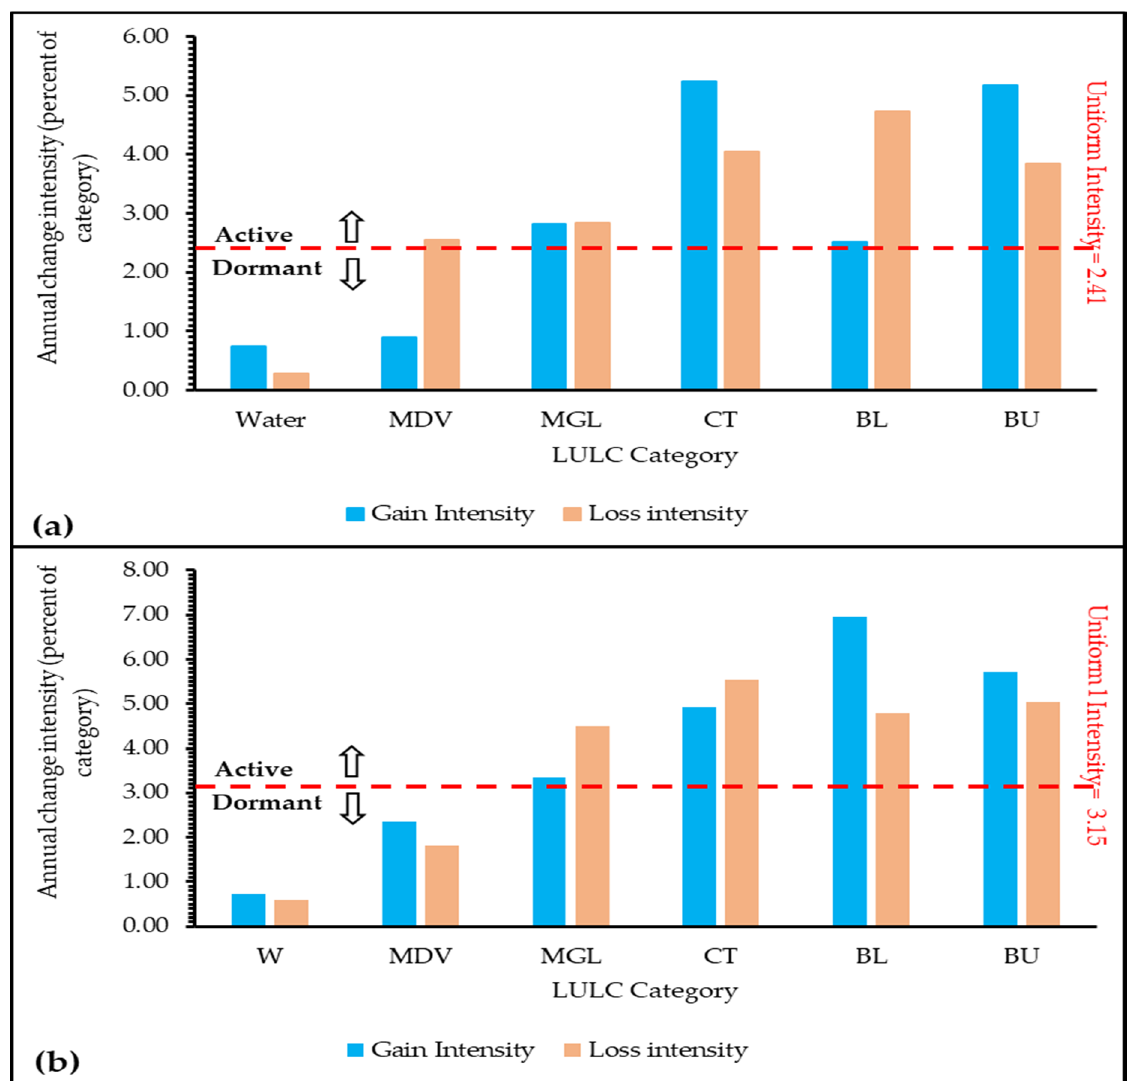
Water 2021 , 13 , x FOR PEER REVIEW